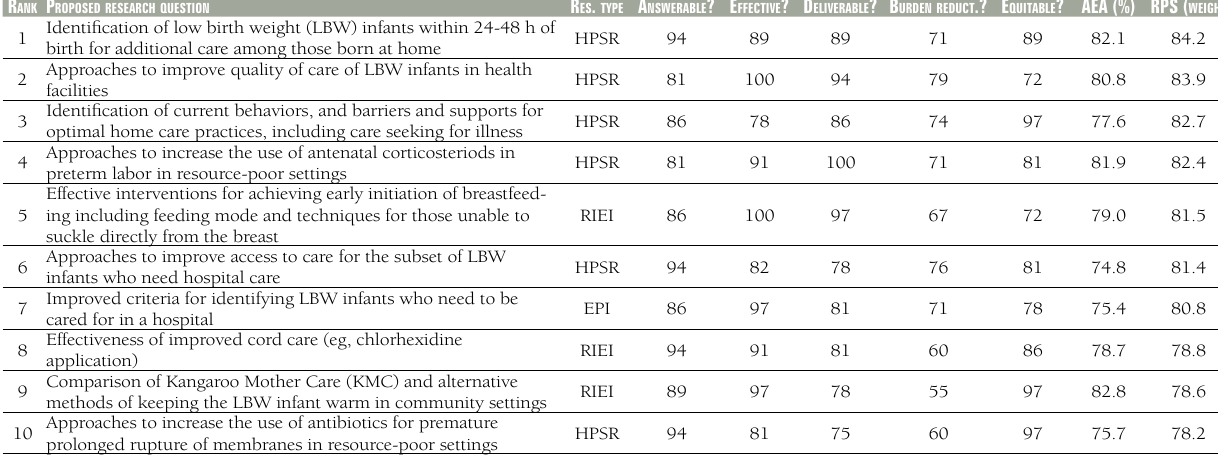
Table 3 Top 10 research questions according to their achieved research priority score (RPS), with average expert agreement (AEA) related to each question